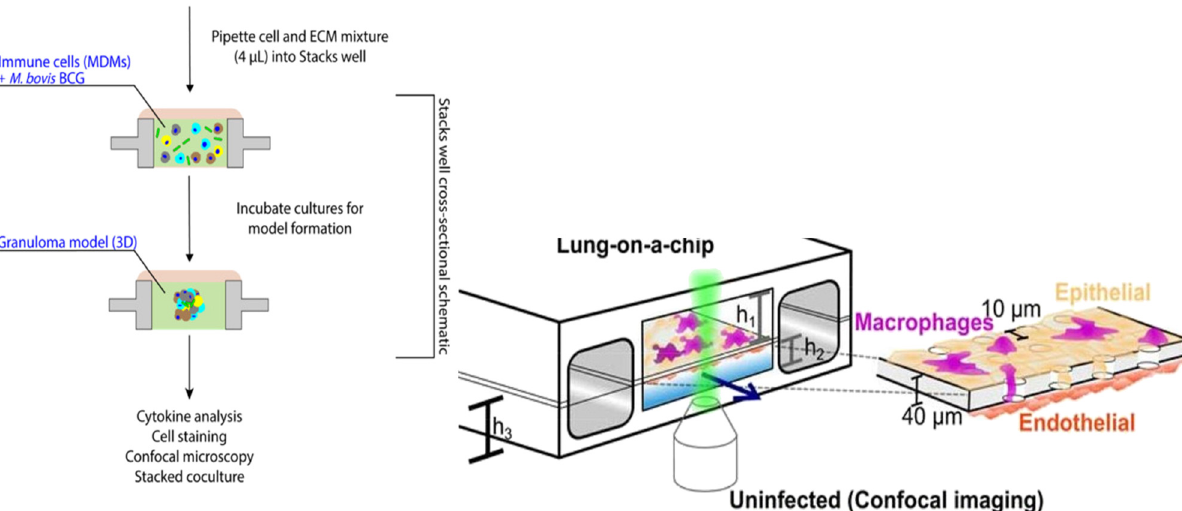
Figure 9: 3D organ - on - a - chip models for Mtb interaction with lung tissue. Left: Work fl ow showing the setup of a micro fl uidic device containing granuloma microspheres grown in a suspended micro fl uidics “ Stack system ” from ref. [ 76 ] . Immune and Mycobacteria cells arrange in collagen matrix into a 3D granuloma model. Right: Schematic representation of the lung - on - a - chip from ref. [ 77 ] . Alveolar epithelial cells and macrophages cover the upper face of the membrane in the air - fi lled alveolar channel, while endothelial cells reside in the lower, liquid - fi lled channel. The tissues able to maintain this interface are infected with Mtb and imaged with confocal microscopy. Images adapted with permission from Front Bioeng Biotechnol. ( left, [ 76 ]) and eLife ( right, [ 77 ])